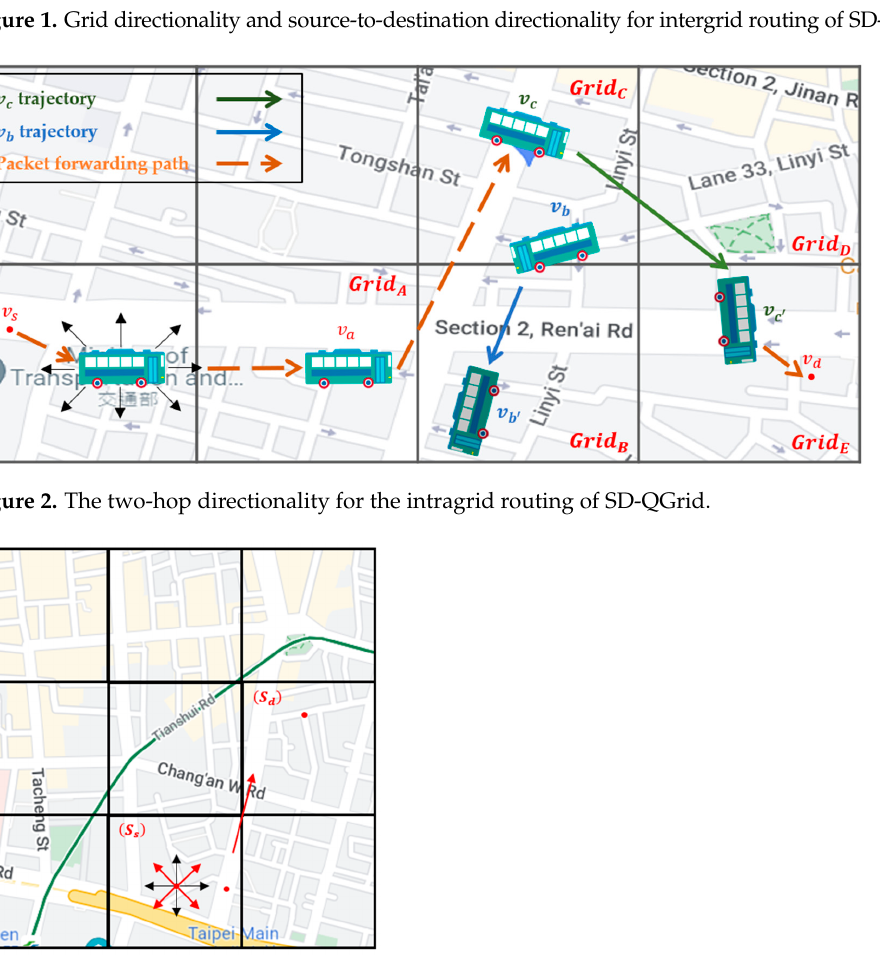
Figure 3. Nodes moving between the current grid and eight neighboring grids in